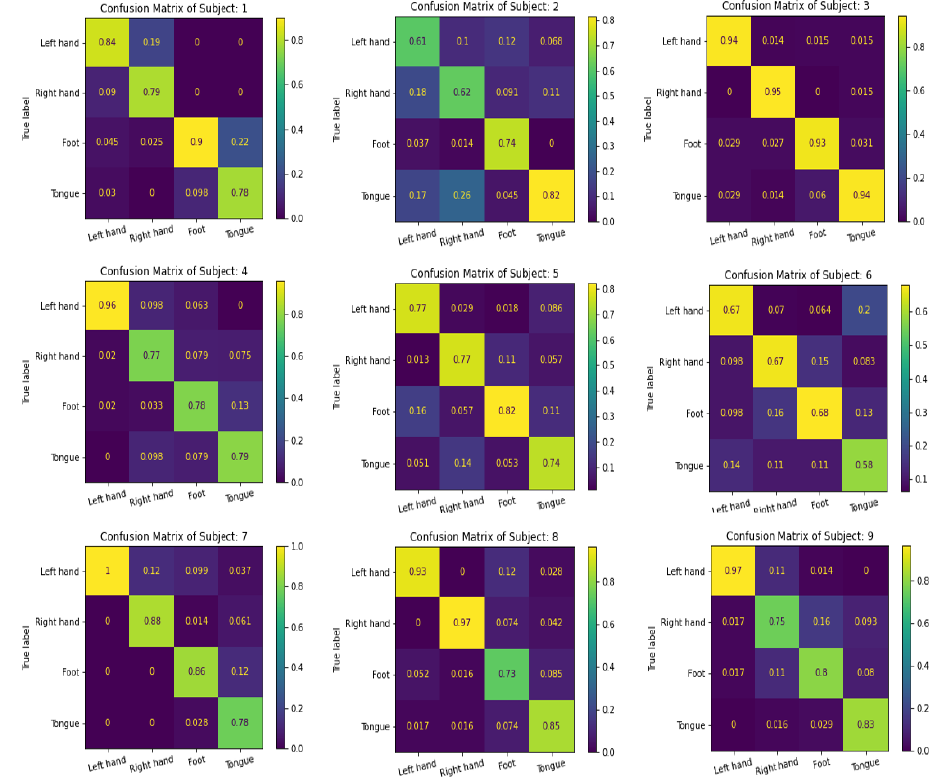
Figure 9. The confusion matrixes of MBShallowConvNet on the MI BCI IV-2a dataset.